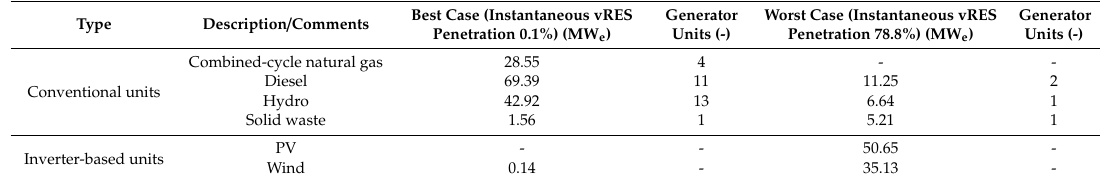
Table 4. Operating conditions for the best and worst cases of the future scenario.